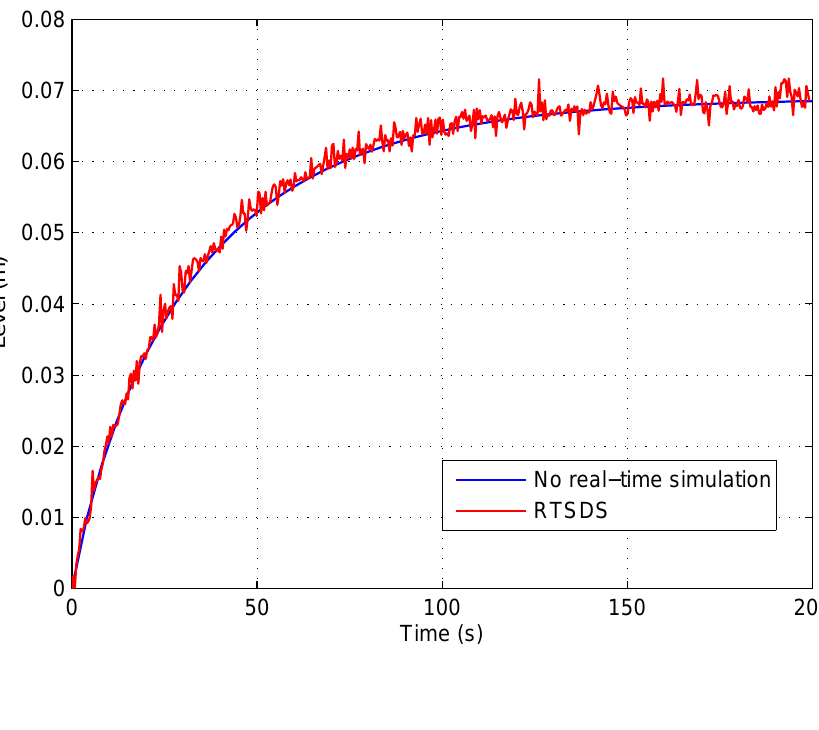
Figure 16. Results obtained for the RTSDS platform applied to the dynamic system characterized by Equation (5), with A = 62 . 072 cm 2 and q